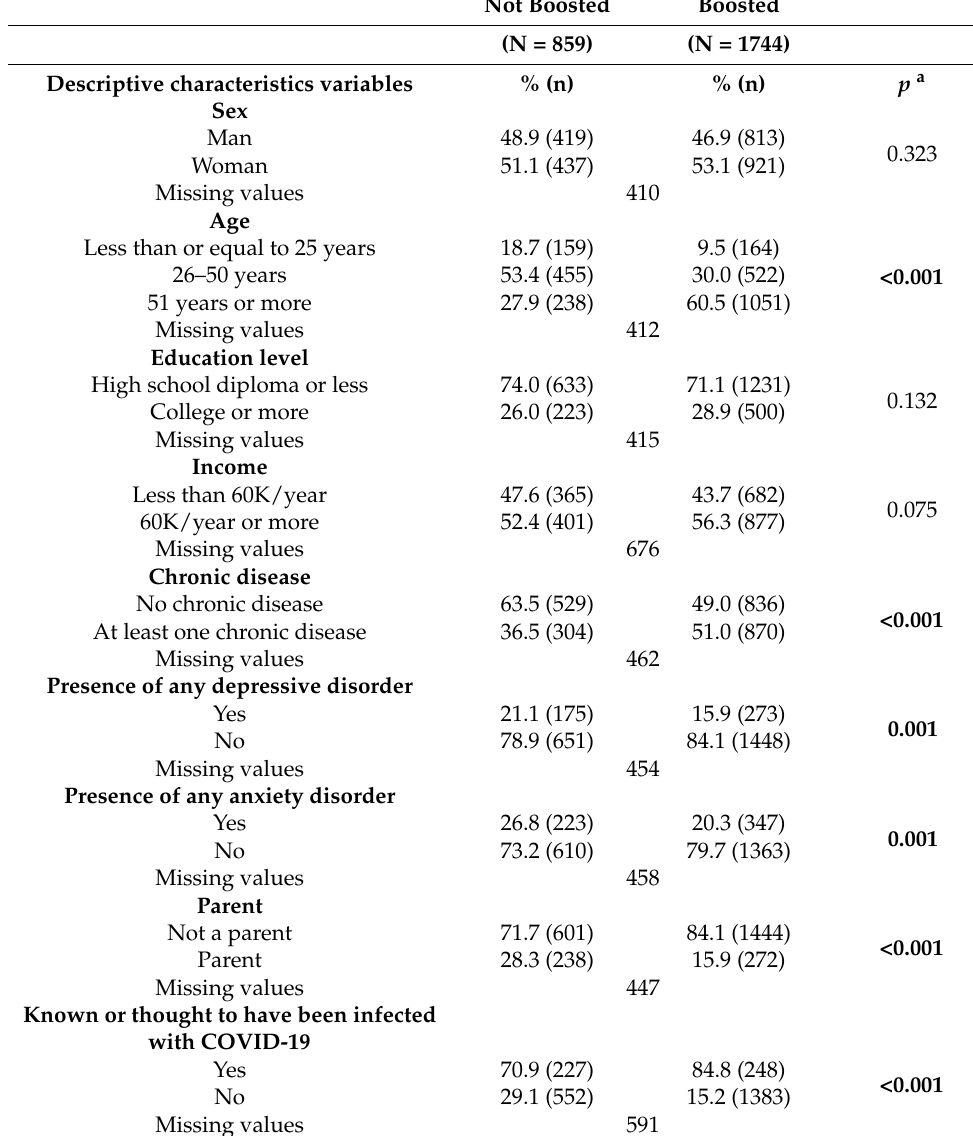
Table 1. Participants’ characteristics as a function of booster vaccination status b